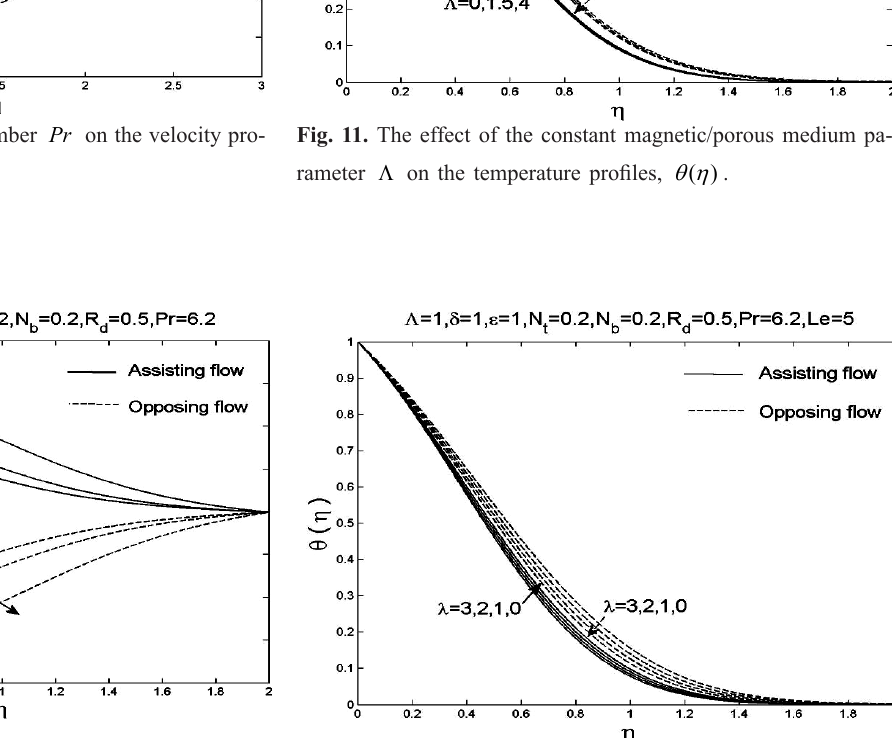
Fig. 10. The effect of the lewis number Le on the velocity profiles ( ) f η′ .